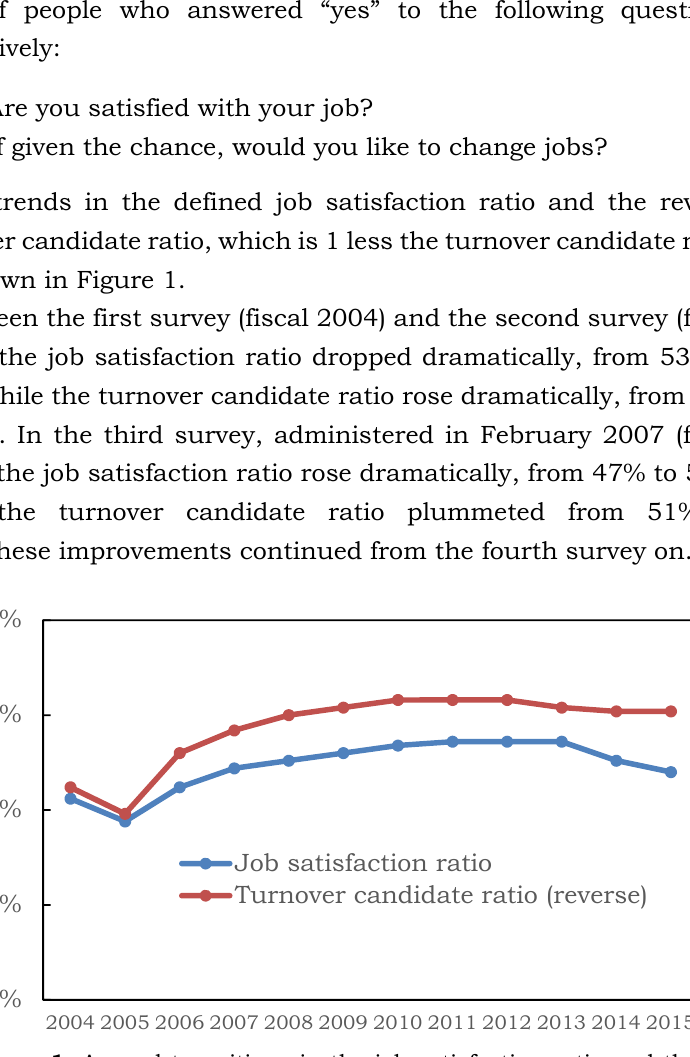
Figure 1. Annual transitions in the job satisfaction ratio and the turnover candidate ratio (reverse) of Company X